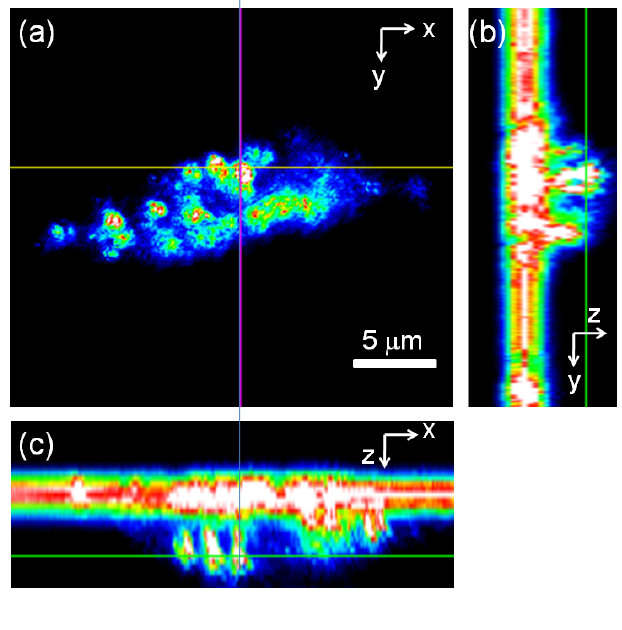
Figure 8. 2D light scattering images of a single PC3 cell incubated with 40 nm gold nanoshells. ( a ) x , y -cross section; ( b ) y , z -cross section; ( c ) x , z -cross section. The thin lines mark the positions where the cross sections have been taken. The bright straight lines in ( b ) and ( c ) are reflections from the cover slide. The cell is visible in ( b ) to the right of and in ( c ) below the cover